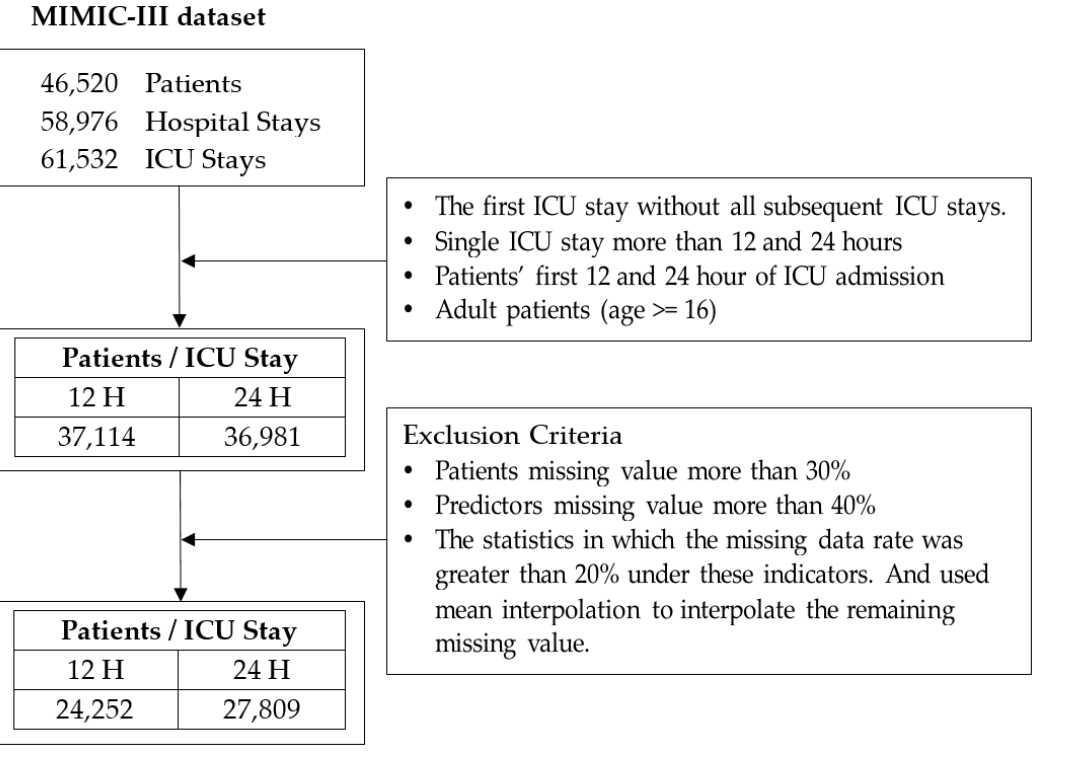
Figure 3. The detailed process of data extraction.